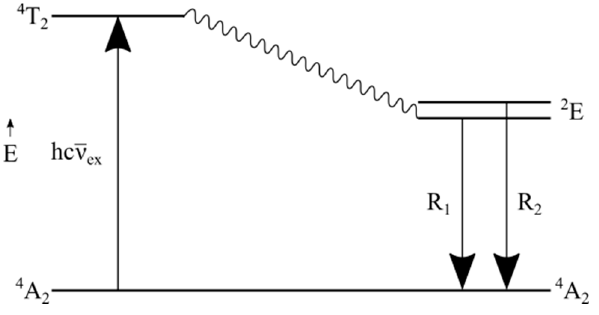
Figure 20. Splitting of the 2 E excited state of ruby gives rise to two closely spaced luminescence bands designated R 1 and R 2 . These bands shift in wavelengths as a function of temperature and also as a function of pressure. At room temperature and pressure λ ( R 1 ) = 694.3 nm and λ ( R 2 ) = 692.7 nm. The ruby temperature calibration range extends from 15–600 K. Increasing pressure redshifts both the R 1 and R 2 luminescence bands. The standard values for the R line shift are +0.0365 nm kbar − 1